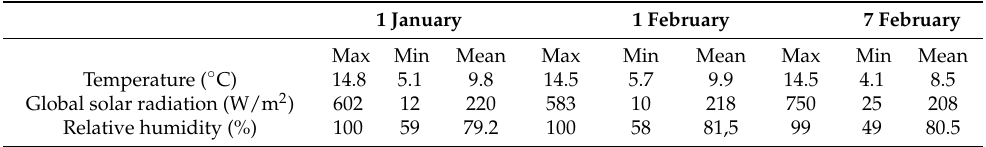
Table 4. Climatic data for reference